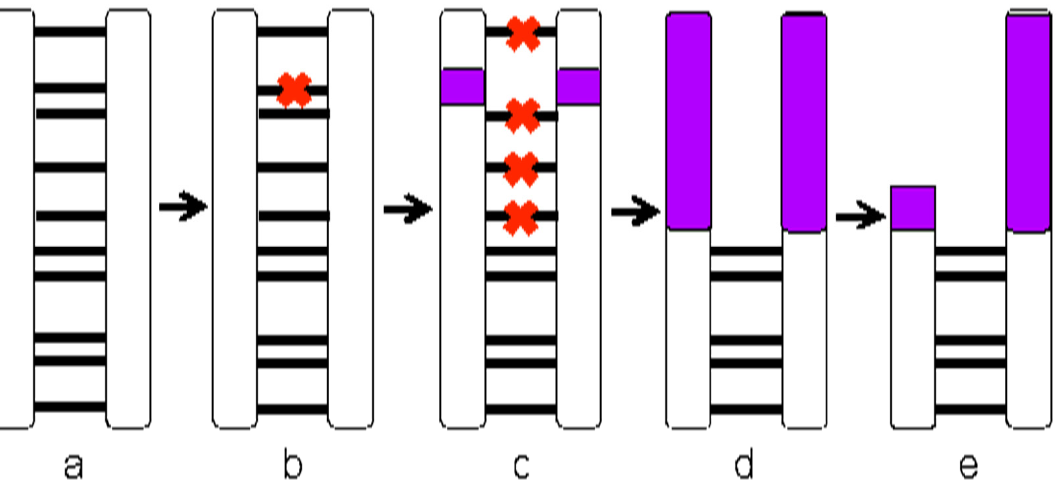
Figure 1. Steps in the evolution of heteromorphic sex chromosomes. White segments of chromosomes indicate that recombination is occurring, while purple areas have ceased recombination and the chromosomal segments are evolving independently. ( a ) Autosomes that fully recombine, ( b ) recombination at a locus (red X) is selected against, ( c ) leading to a loss of recombination, ( d ) over time, additional loss of recombination may occur, possibly with changes in gene content and structure, and ( e ) finally there may be potential loss of some genetic material from one chromosome. At all steps, part of the chromosome continues to recombine to allow pairing during meiosis.